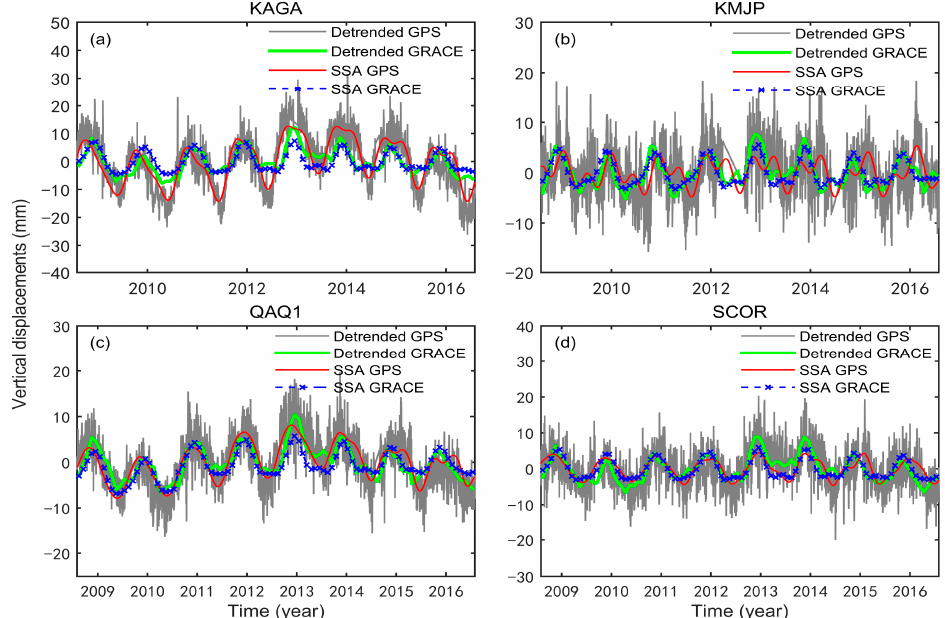
Figure 10. Vertical coordinate time series (detrended) and seasonal periodic signals of the GPS and GRACE experimental stations.